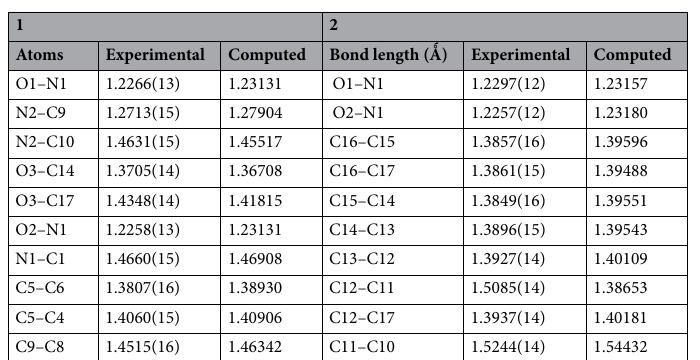
Table 2. Selected Experimental and calculated bond lengths (Ǻ) of 1 and 2